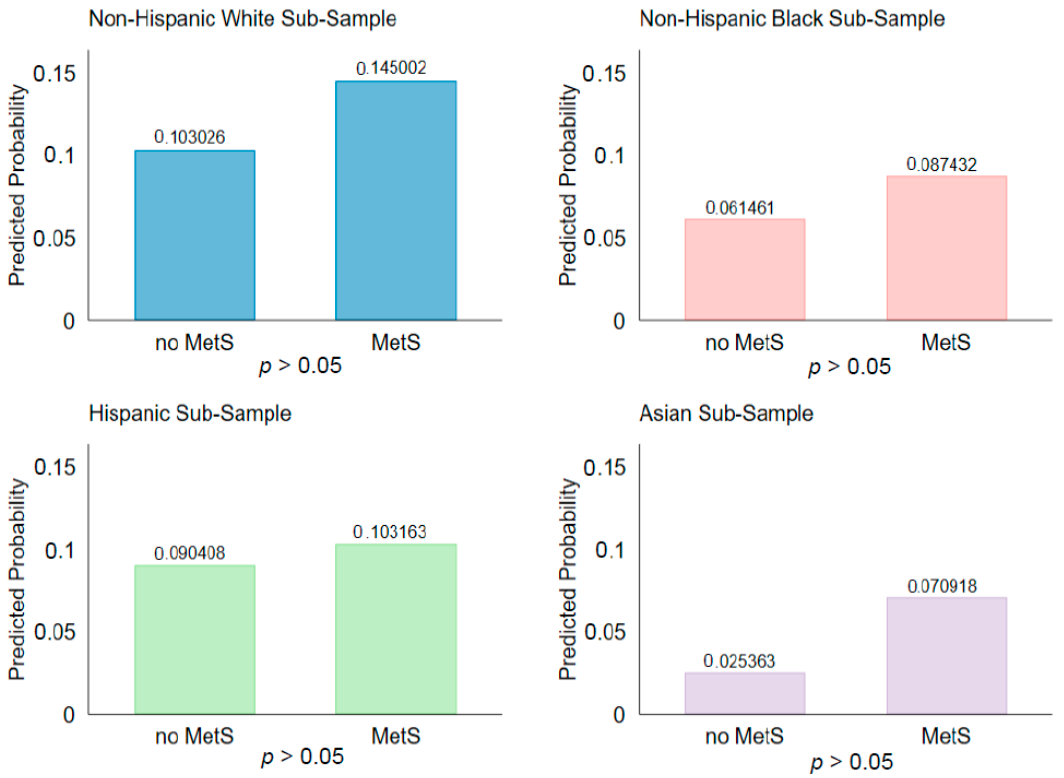
Figure 1. Predicted probability of cancer by metabolic syndrome status, separately for each racial/ethnic Group, NHANES 2011–2018. Table 2. Binary logistic regression results of the association between cancer and MetS with covari- ates, NHANES 2011–2018.